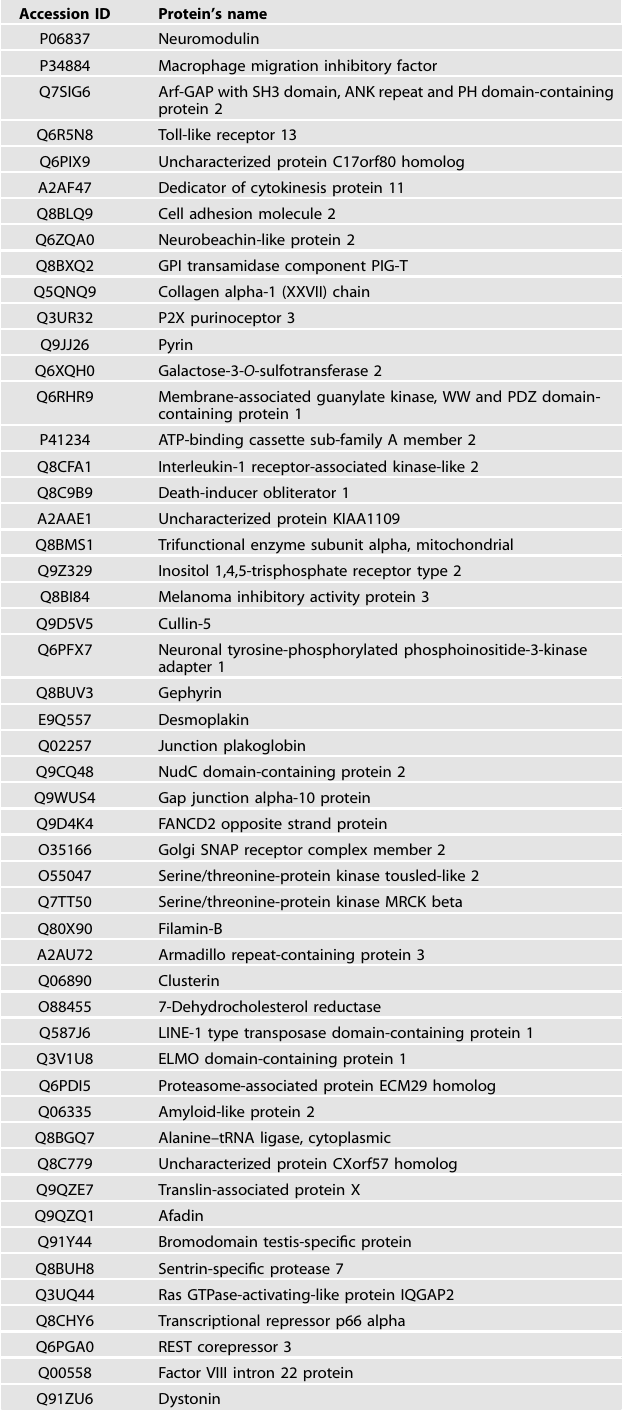
Table 1. The shared SNO-proteins between ASD and AD